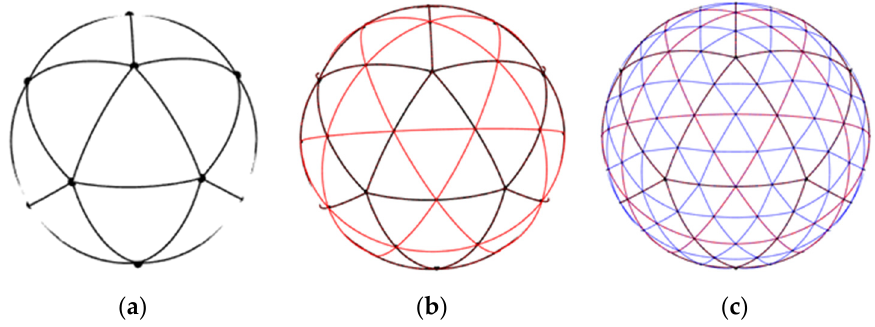
Figure 1. The triangle mesh based on a regular icosahedron sphere. ( a )The initial triangle mesh generated by regular icosahedron embedded in the sphere, with edges projected to the surface; ( b ) icosahedron triangle mesh with refinement level 1, with newly added edges denoted via thinner red lines; ( c ) icosahedron triangle mesh after two stages of refinement, newly added edges are shown in blue lines.